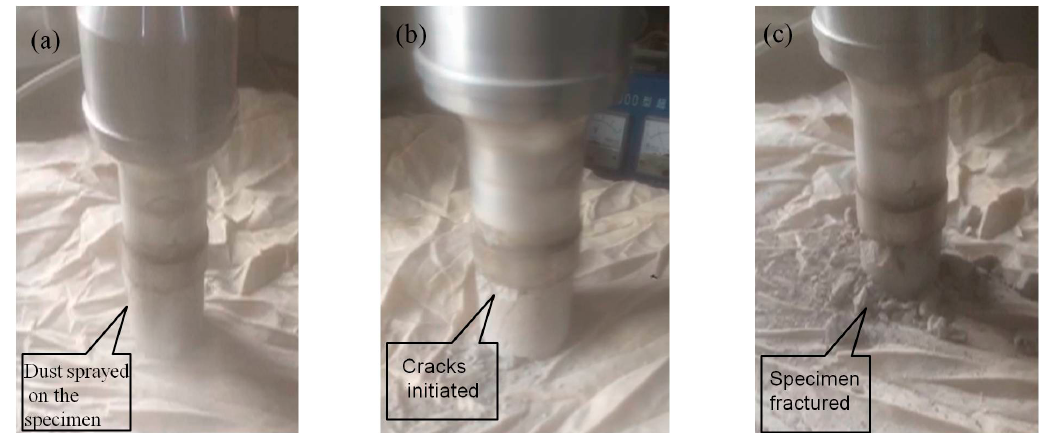
Figure 5. The test process of ultrasonic vibration excitation: ( a ) at the start; ( b ) during the test; and ( c ) after finished